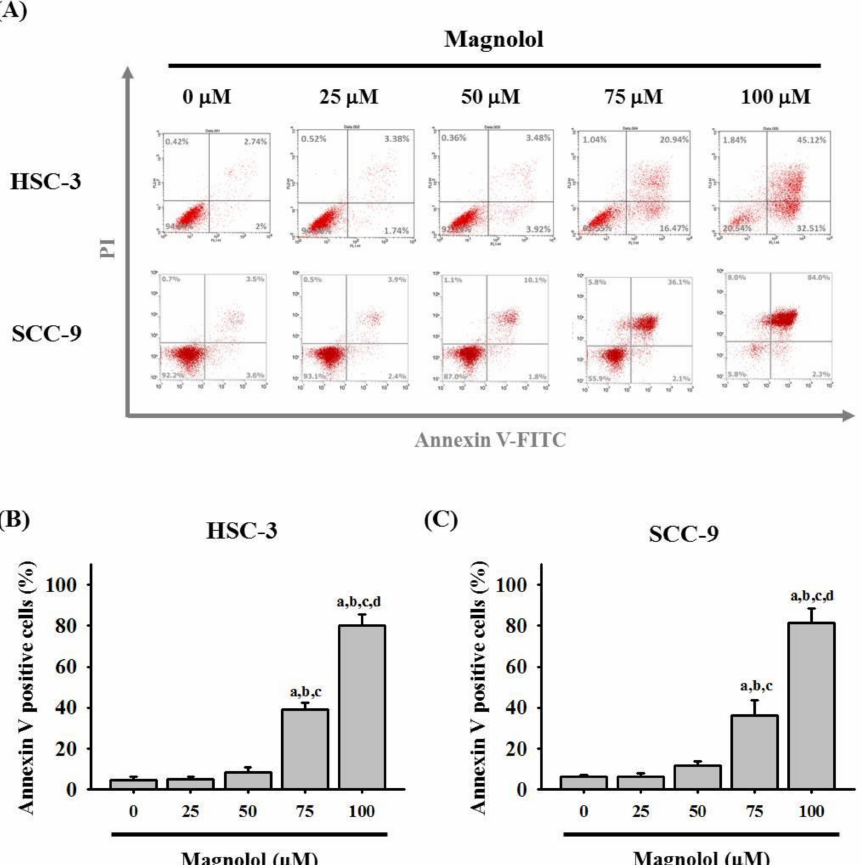
Figure 3. Magnolol induced HSC-3 and SCC-9 cell apoptosis. ( A ) After treatment with magnolol (0, 25, 50, 75, and 100 µ M) for 24 h, HSC-3 and SCC-9 cells were treated with Annexin V-FITC and PI and analyzed through flow cytometry, as described in the Materials and Methods section. Quanti- tative Annexin V positive cells were induced by magnolol on ( B ) HSC-3 cells and ( C ) SCC-9 cells in a dose-dependent manner. The data represent the mean ± SD of three independent experiments. a Significantly different, p < 0.05, when compared to control. b Significantly different, p < 0.05, when compared to 25 µ M. c Significantly different, p < 0.05, when compared to 50 µ M. d Significantly different, p < 0.05, when compared to 75 µ